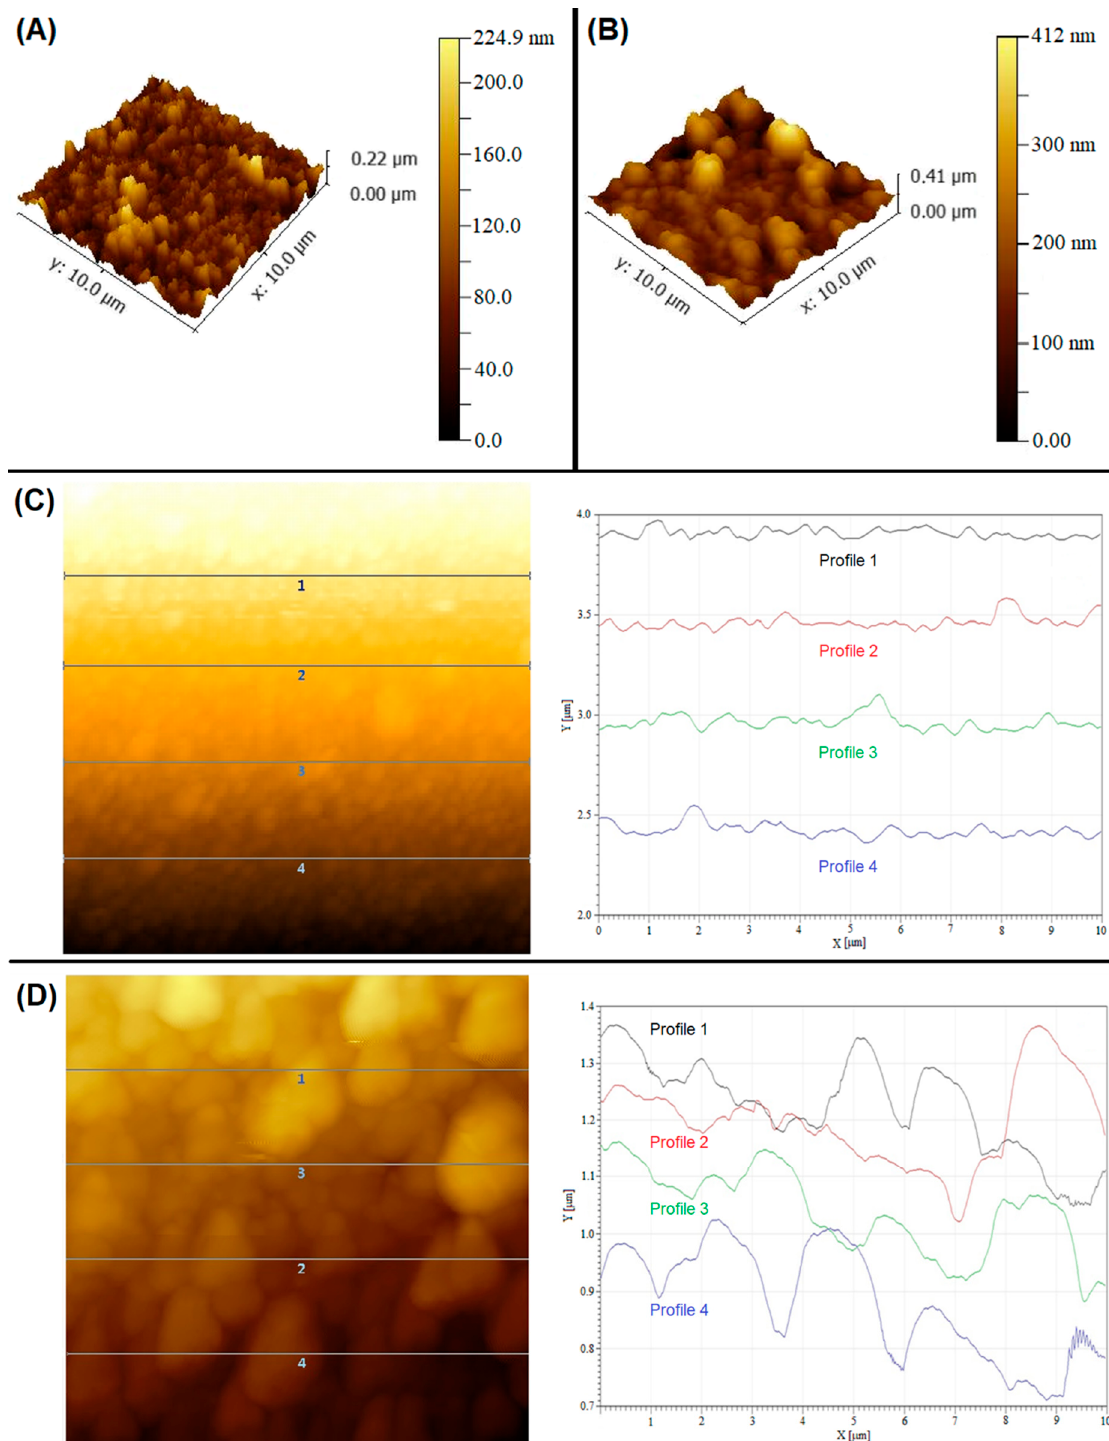
Figure 2. Dimensional AFM images for the ( A ) unmodified platinum electrode surface and ( B ) platinum electrode coated with poly-Pd(salen) grown in acetonitrile containing 0.10 mol L − 1 tetrabutylammonium hexafluorophosphate electrolyte. AFM morphology images of the unmodi- fied ( C ) and modified platinum electrode surfaces ( D ) with the respective cross-section profiles of the